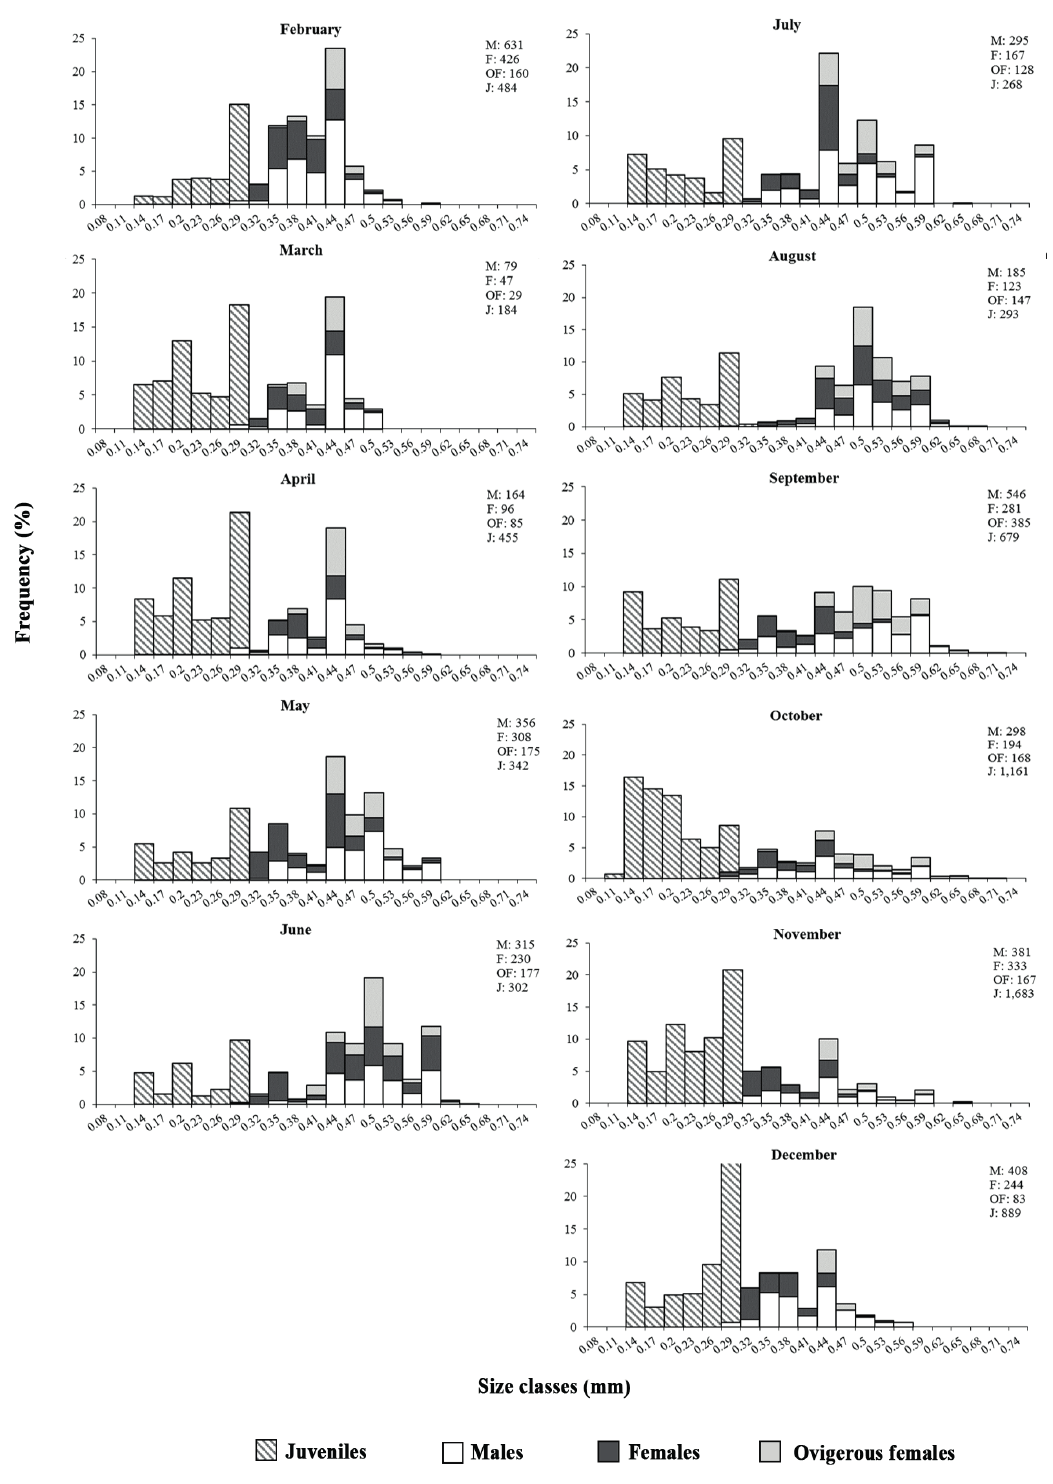
Figure 5 - Monthly size-frequency distribution of H. pampeana at site 2 (year 2006). The numbers in the right corner of each graph represent the number of juveniles (J), males (M), females (F) and ovigerous females